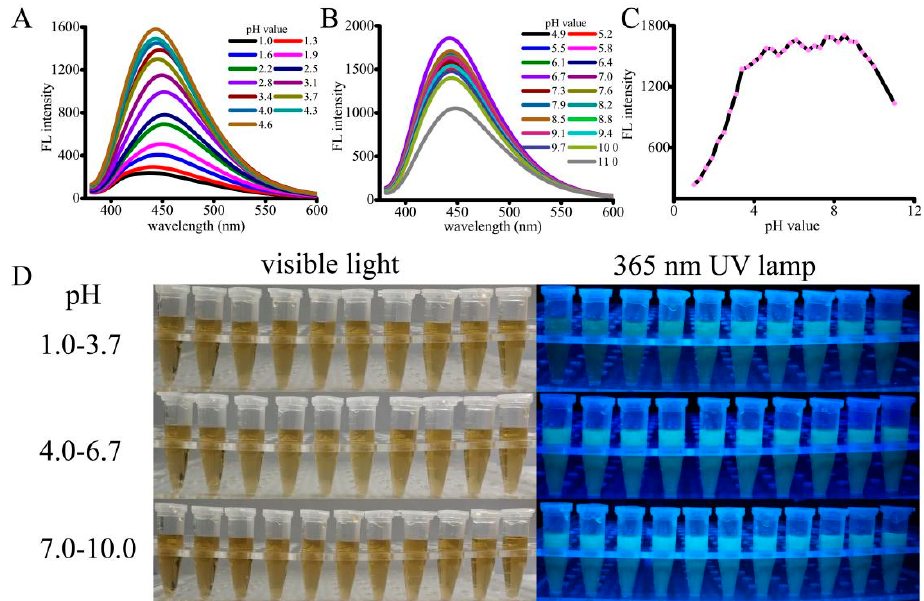
Figure 2. In vitro pH-dependent fluorescence and luminescence behaviors of CNPs: pH-sensitive fluorescence spectra of the CNPs, ranging from pH 1.0 to 4.6 ( A ) and 4.9 to 11.0 ( B ) at 363 nm excitation; ( C ) pH-sensitive fluorescence intensity of the CNPs with respect to change in pH value. ( D ) The photographs of CNP solution under visible light and a 365 nm UV lamp.